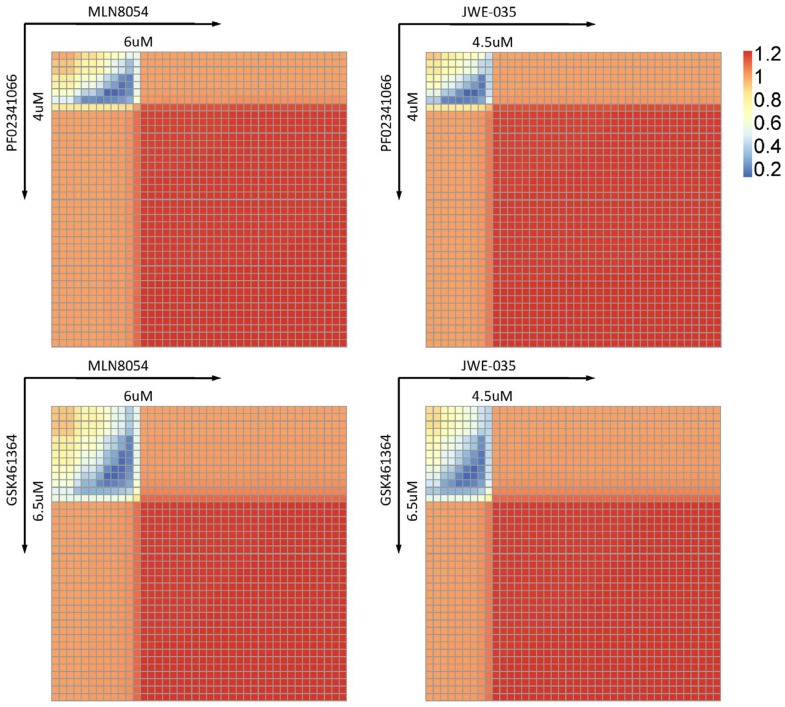
Combination effect of different kinase inhibitors.The combination effect is: I) synergy, if CIBliss(x,y)<1. II) additivity, if CIBliss(x,y) = 1. III) antagonism, if CIBliss(x,y)>1.